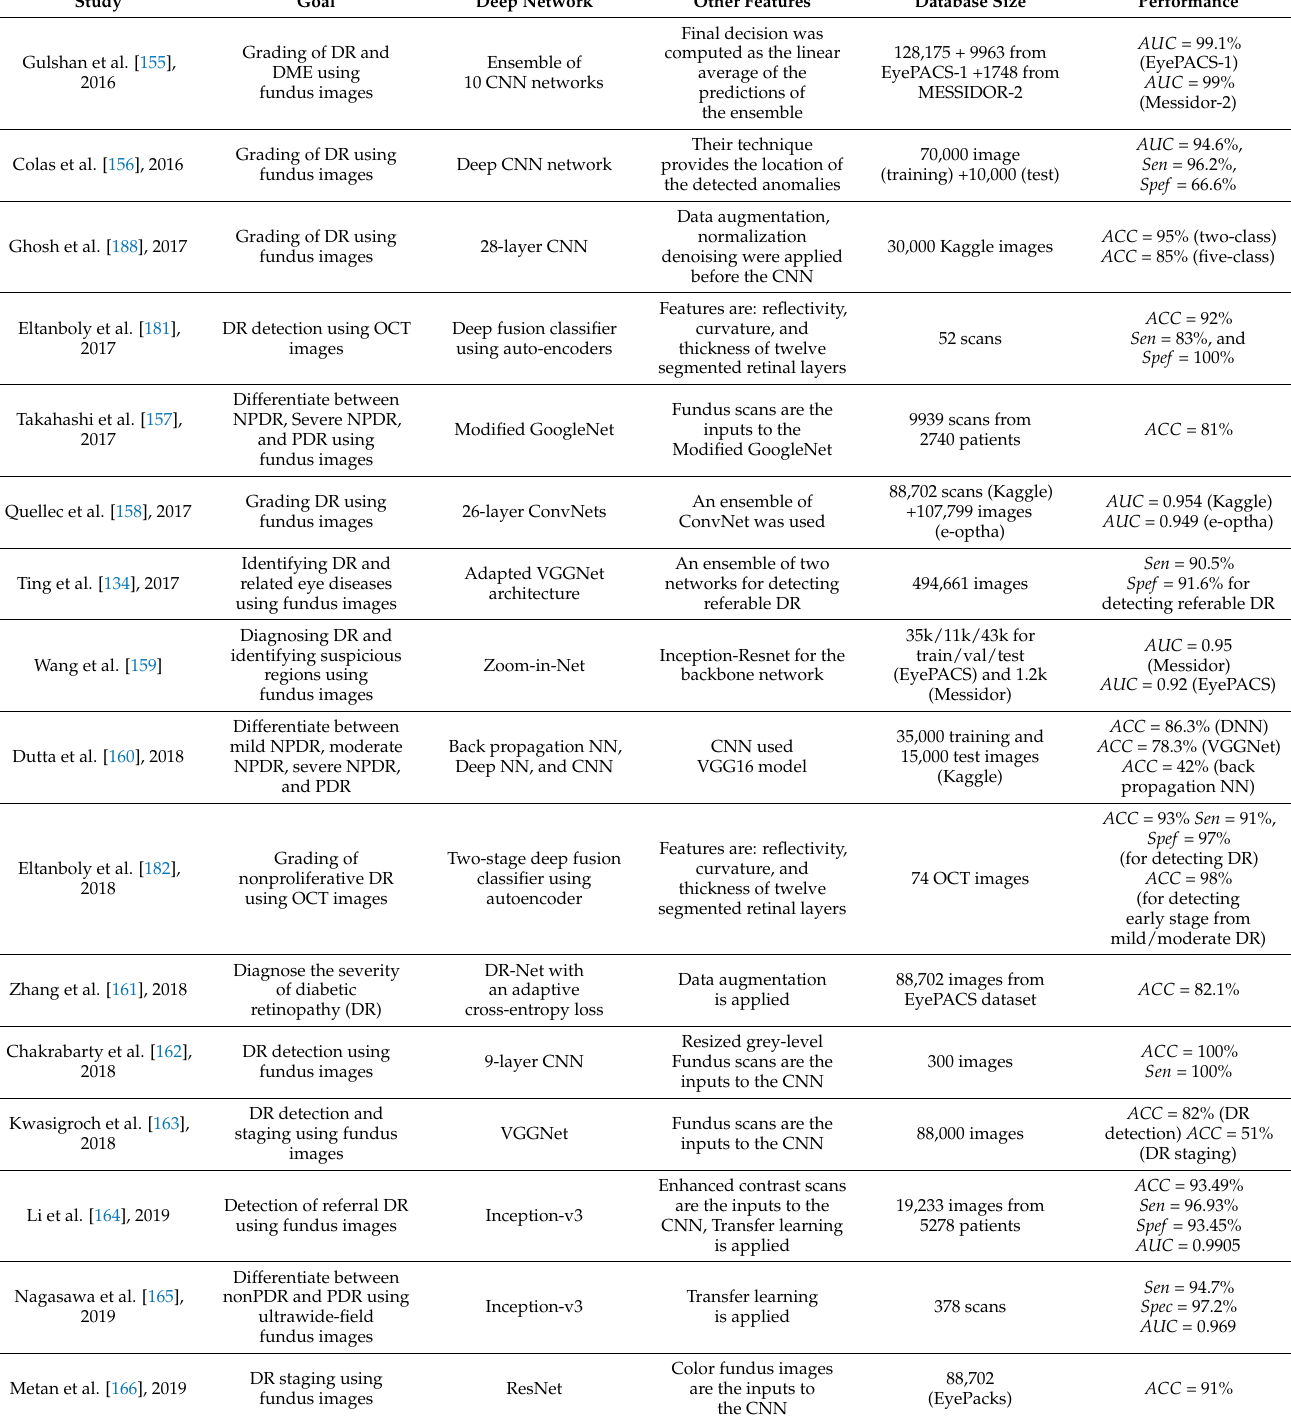
Table 2. Deep learning methods for early detection, diagnosis, and grading of